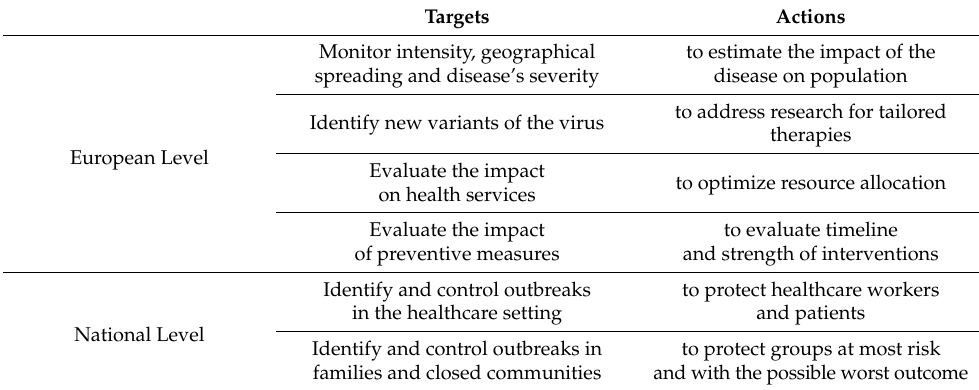
Table 1. ECDC targets of COVID-19 surveillance (modified from